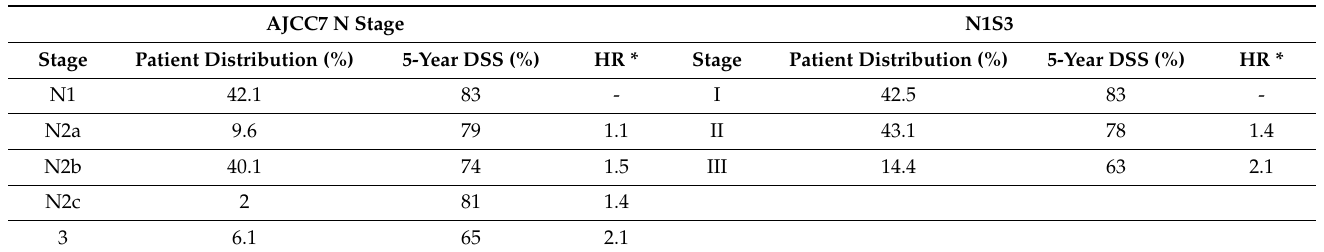
Table 2. Comparison of the AJCC7 and N1S3 staging systems for HNcSCC nodal